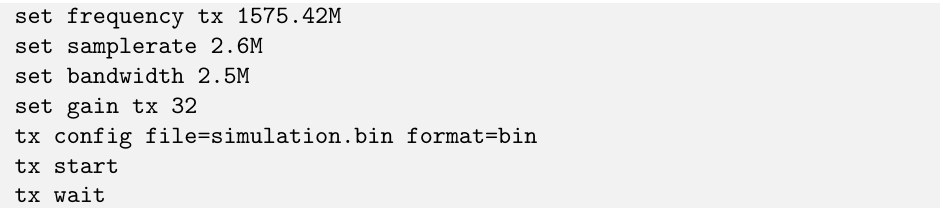
Figure 6. Script used to obtain ephemerises and create the gps-sdr-sim bitstream.